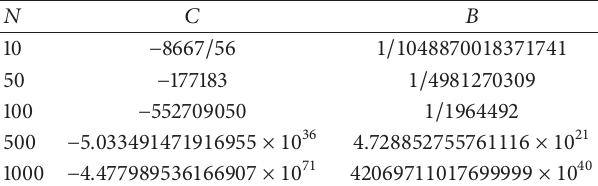
Table 1: Determinants of the